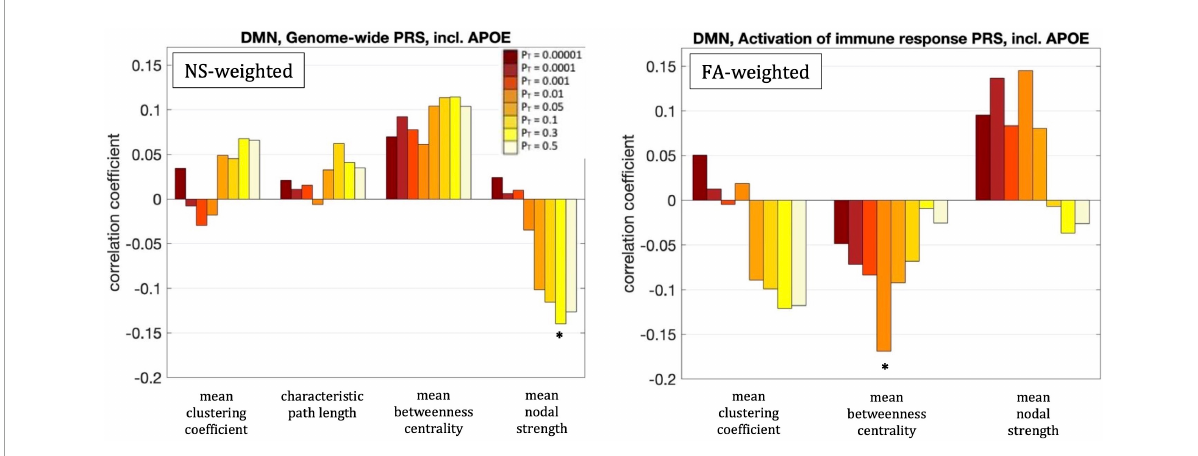
FIGURE5 Correlation coefficients between the graph theoretical metrics of the default-mode network and the genome-wide PRS including APOE for the eight different values of P T . The asterisk indicates the instances in which the p -value survived multiple comparison correction.